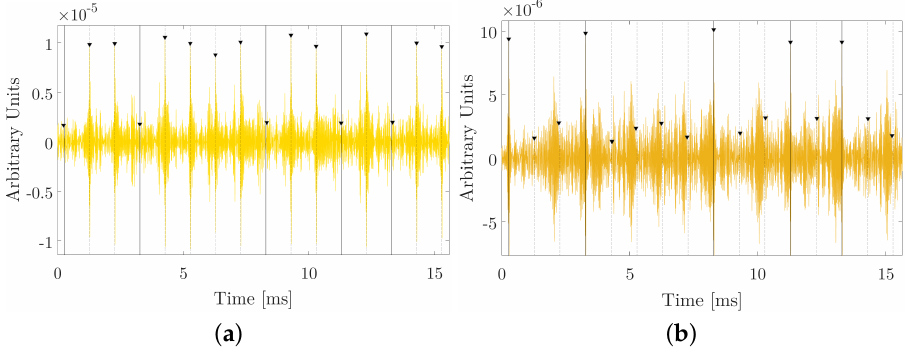
Figure 8. Frequency and correlation analysis. ( a ) Cross-correlation between the received signal and bit 1 upward from 10 until 50 kHz; ( b ) Cross-correlation between the received signal and bit 0 downward from 50 to 10 kHz at 1000 µ s duration